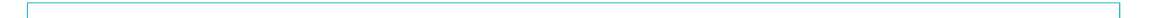
Figure 2: The Janus-faced role of autophagy in cancer. In healthy cells macroautophagy has a tumour suppressor function. As a catabolic survival mechanism, it ensures optimal energy supply, preserves genetic and genomic stability, maintains normal stem cells, is involved in the degradation of oncogenes, and is the first line defence against bacterial or viral infection. During tumour formation downregulation of au- tophagy is frequently observed, possibly supporting tumor development. In established tumours, however, autophagy functions can be re- stored and instead support tumour development. This occurs, for example, via (a) supporting EMT and metastasis, (b) rendering cells resistant to anoikis (programmed cell death upon detachment), (c) counteracting metabolic and oxidative stress, (d) maintaining cancer stem cells and supporting the senescent cell state, and (e) promoting chemo- as well as radiotherapy